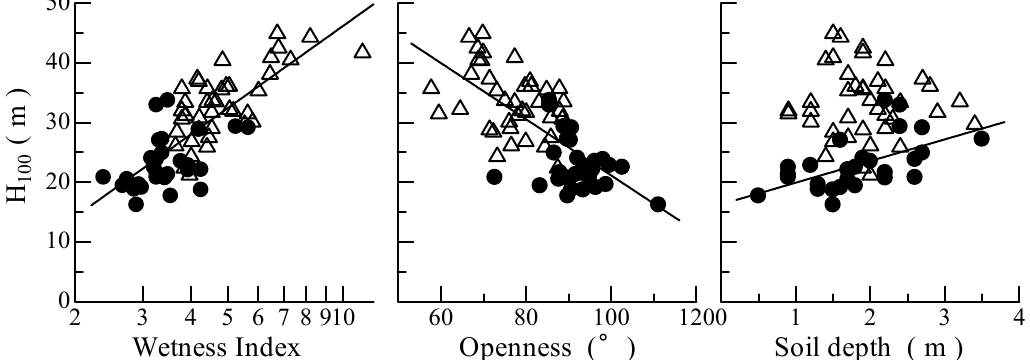
Figure 1. Relationships between tree heights and wetness index, openness, or soil depth ( n = 68). The x axis in the left panel is a logarithmic scale. Filled circles indicate the plots on the ridges ( n = 28) and open triangles indicate the plots on the middle or lower sections of the slopes ( n = 40). The regression lines were shown in the figure. For soil depth, the regression line obtained from the plots on the ridges is shown.